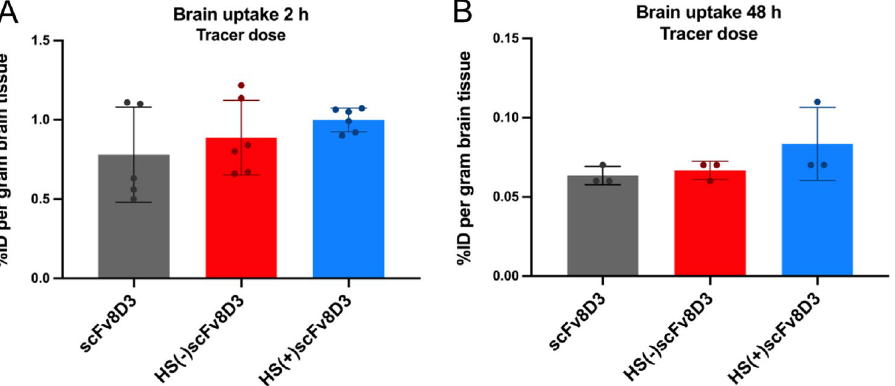
Figure 6. Brain uptake of tracer doses of [ 125 I]scFv constructs. ( A ) The brain uptake of the three [ 125 I]scFvs at 2 h post injection. [ 125 I]scFv8D3 (n = 5), [ 125 I]HS(−)scFv8D3 (n = 6) and [ 125 I]HS(+)scFv8D3 (n = 6). ( B ) The brain uptake of a tracer dose of the three [ 125 I]scFvs at 48 h post injection. [ 125 I]scFv8D3 (n = 3), [ 125 I]HS(−) scFv8D3 (n = 3) and [ 125 I]HS(+)scFv8D3 (n = 3). Results are presented as mean ±